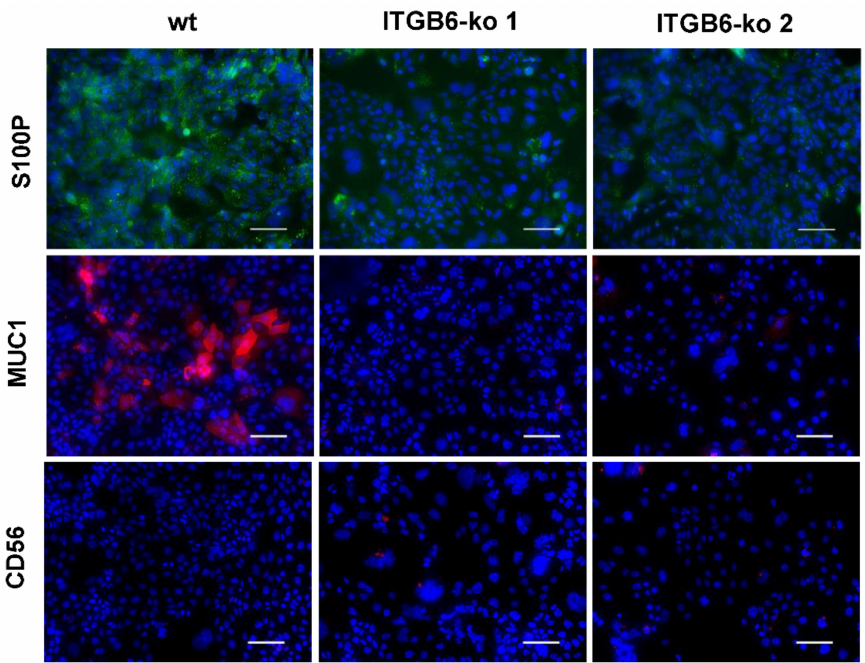
Figure 6. Immunofluorescence staining of S100 calcium-binding protein P (S100P), mucin 1 (MUC1), and CD56 in HuCCT1 wild-type (wt) and integrin β 6-knockout ( ITGB6 -ko) cells. The expressions of S100P (green) and MUC1 (red) decreased in ITGB6 -ko cells compared with wild-type cells, whereas the expression of CD56 (red) showed slight increase in ITGB6 -ko 1. (Scale bar, 100 µ m). 2.6. Relationship between PODXL2 Expression and Clinicopathological Features in Patients with Intrahepatic Cholangiocarcinoma (iCCA) Positive immunohistochemical staining for PODXL2 were observed in 17 (32.7%) of 52 iCCAs. PODXL2 expression was localized in the cell membrane and cytoplasm. The correlations between PODXL2 expression and the localization, histological differentiation, growth type, serosa invasion, and bile duct invasion of iCCA were statistically significant (Table 4). PODXL2 expression was higher in the non-peripheral central localization type iCCA than in the peripheral localization type ( p = 0.0197); lower in the poorly differentiated type than in the well-differentiated type ( p = 0.0104); and higher in the infiltrative-growth type than in the expansive-growth type ( p = 0.0223). High expression was related to serosa invasion and bile duct invasion ( p = 0.0239 and 0.0038, respectively). Table 4. Relationship between PODXL2 expression and clinicopathological characteristics of intrahepatic cholangiocarcinoma. Number of